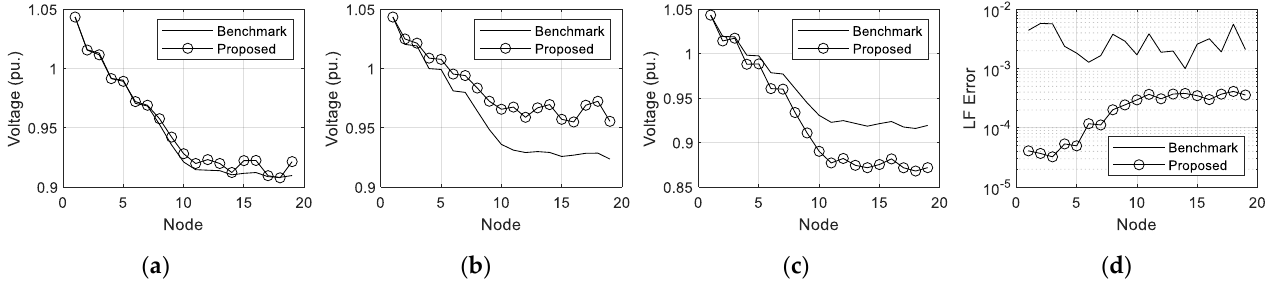
Figure 11. Comparison between benchmark and proposed methods at ( a ) Phase − AN, ( b ) Phase − BN, ( c ) Phase − CN, and ( d ) errors in LF results.